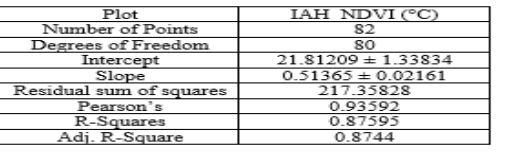
Table 4. The correlation coefficient results for in-Situ Vs UAV